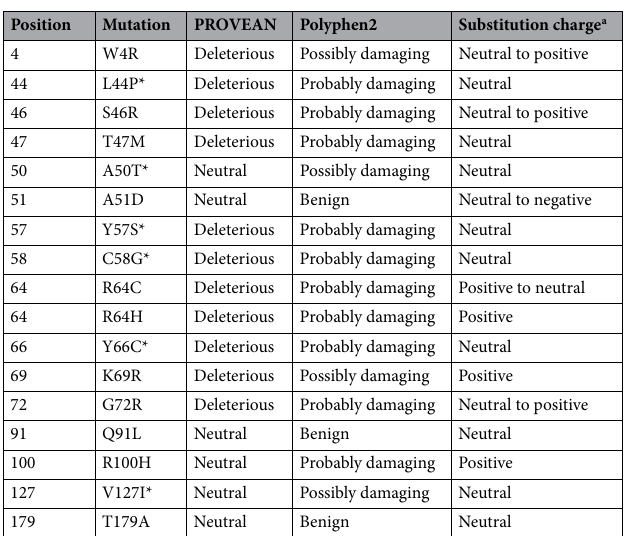
Table 1. HCM/DCM mutations and their severity based on PROVEAN and Polyphen2 prediction. a Change in residue charge property when original amino acid residue is substituted with mutational residue. Asterisks (*) marked mutations are LIM domain specific mutations that are predicted to be de-stabilising in our stability